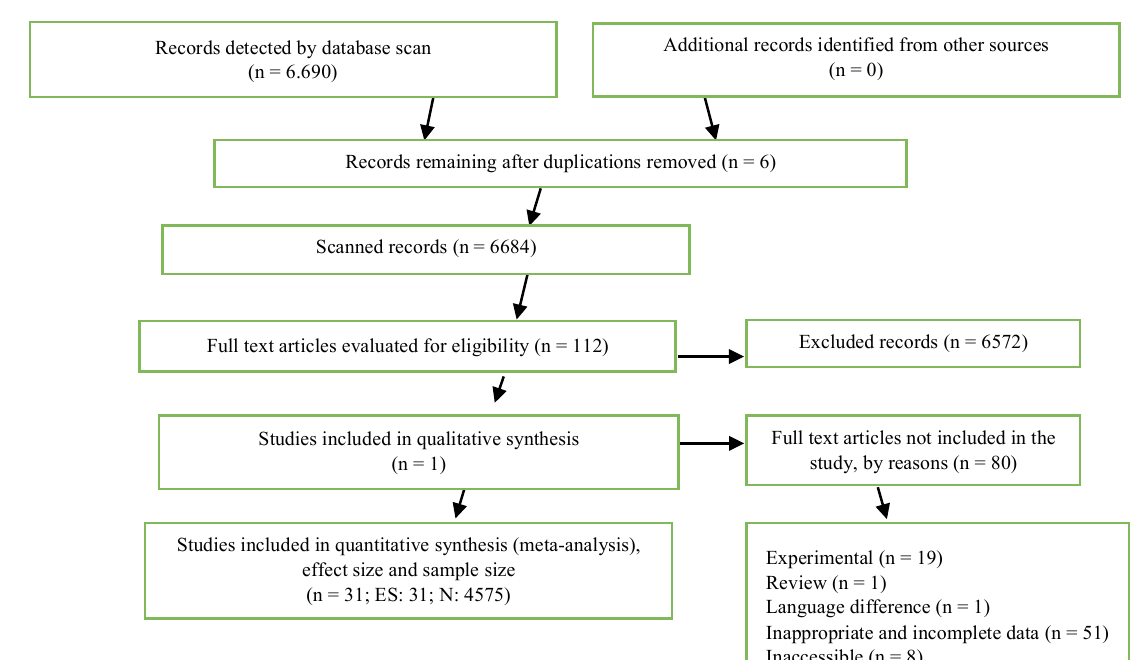
Figure 1. PRISMA flow